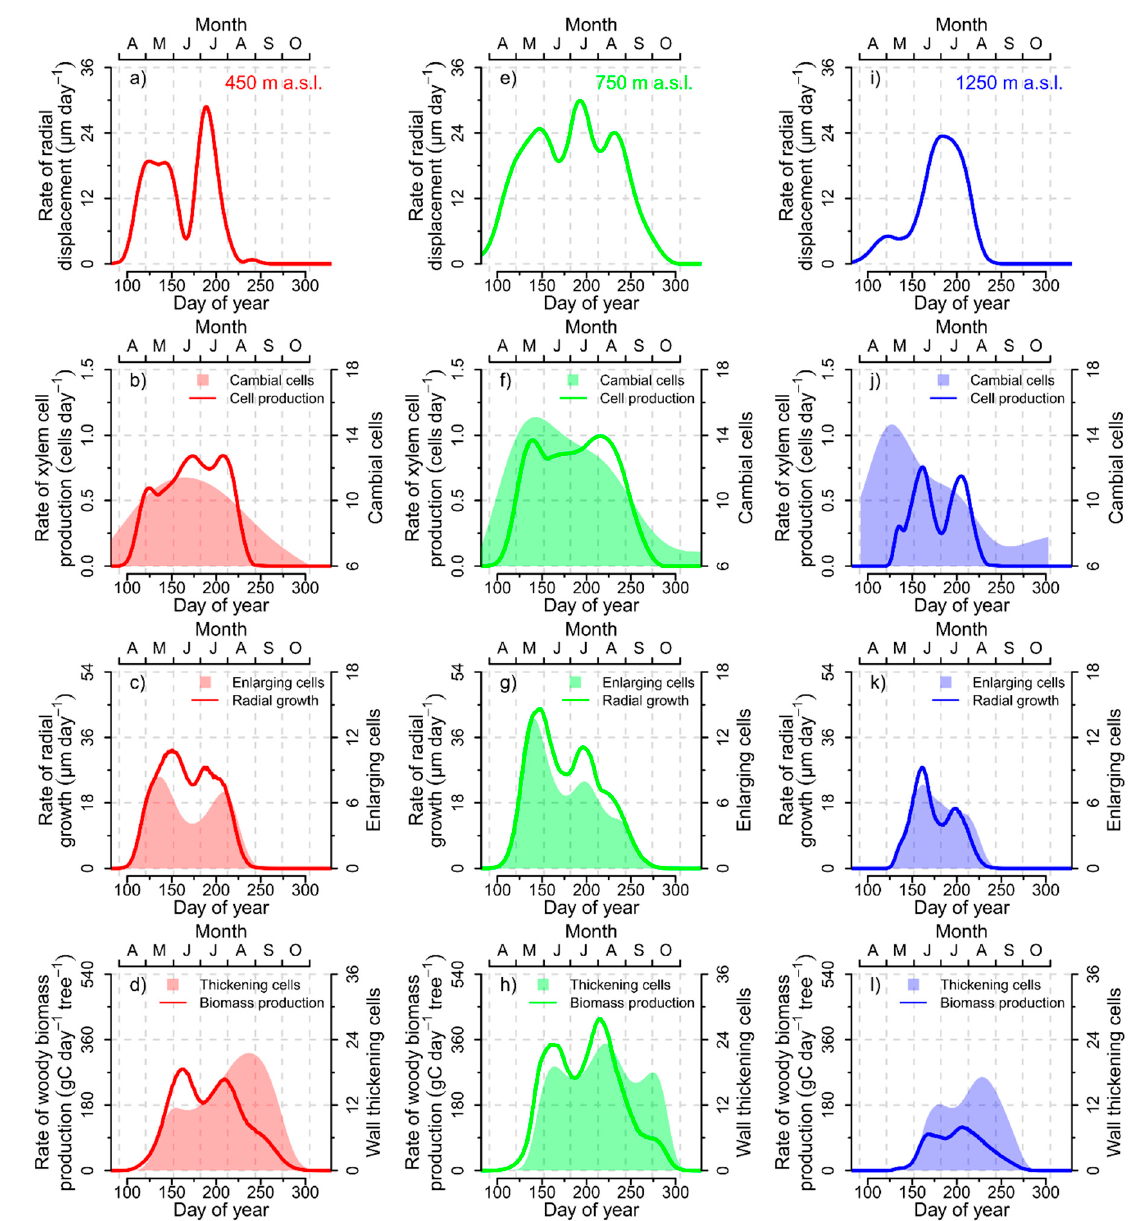
Figure 7. ( a ) Daily rate of stem radial displacement, ( b ) daily rate of xylem cell production and number of cambial cells, ( c ) daily rate of radial xylem growth and number of enlarging cells, and ( d ) daily rate of woody biomass production and number of cells in secondary wall thickening for the 450 m a.s.l. elevation site. The same list of variables is displayed for the 750 m ( e–h ) and 1250 m a.s.l ( i–l ) elevation sites, respectively.